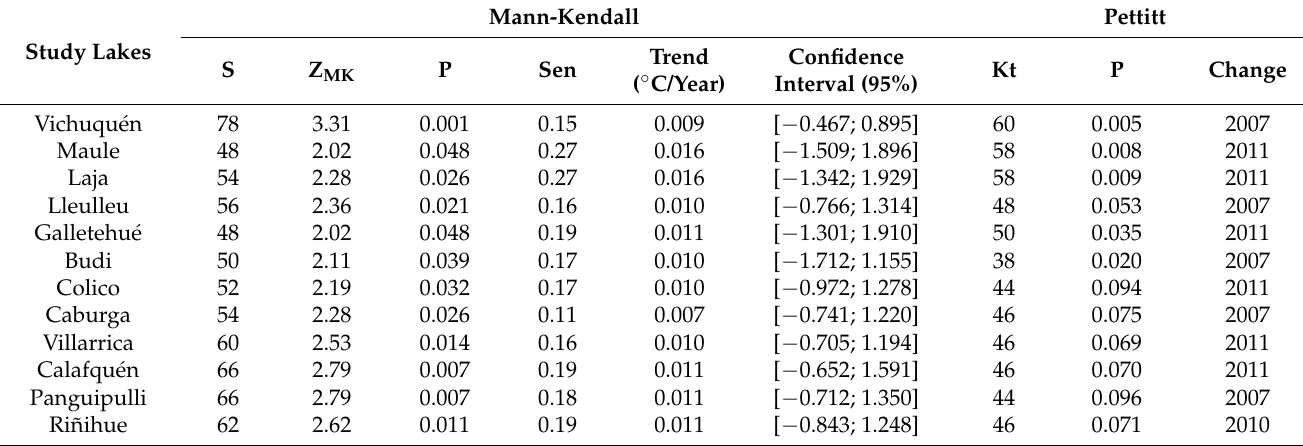
Table 3. Test results of Mann–Kendall and Pettitt tests for the month of January of the MODIS LSWT series (2000–2016).